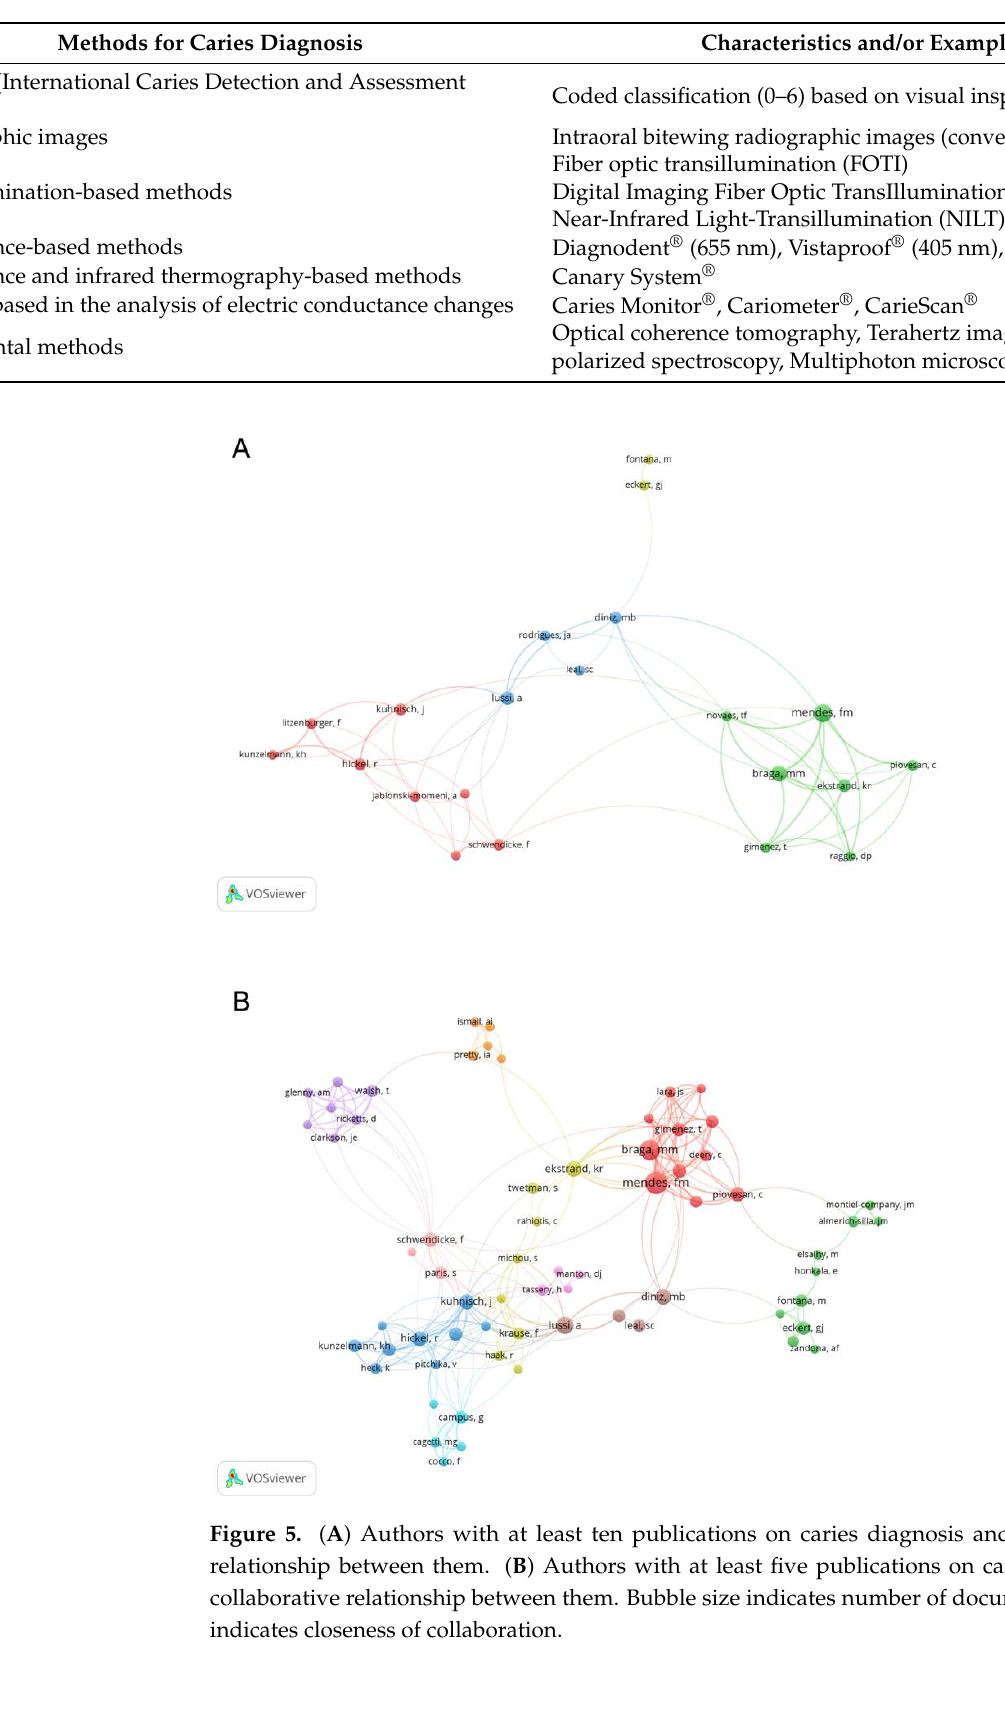
Table 1. Assessed methods for caries diagnosis.